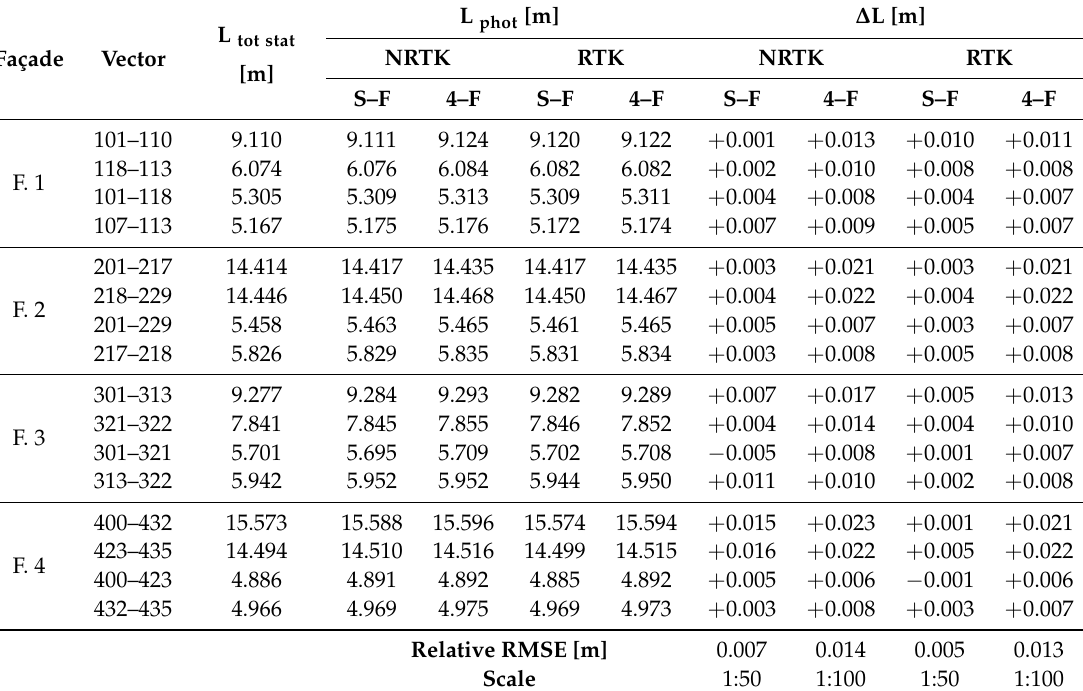
Table 11. Quality assessment of the S–F and 4–F models through vectors between SPs located on a same façade (vectors are illustrated in Figure 12 on the right side). Relative RMSE together with the scale whose metric survey specifications were satisfied are also reported.